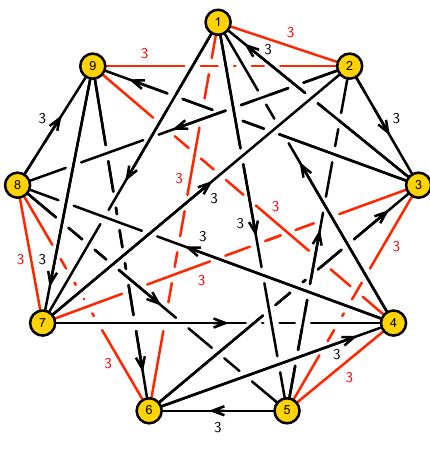
Figure 12 . Quiver for Y 3 , 0 ( CP 2 )